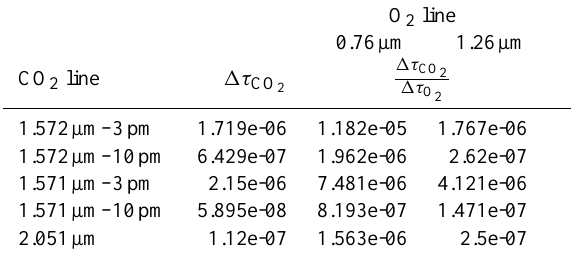
Table 1. Temperature- and humidity-induced weighting function (cid:49)τ CO2 relative uncertainty for (cid:49)τ CO (first column) and . The val- (cid:49)τ O2 2 ues for σ (cid:49)ξ (h) were computed using Eqs. (A7–A9) and the pro- ((cid:49)τ CO ) , while files in Figs. 4 and 5. The value for (cid:49)τ CO is σ 2 (cid:49)ξ 2 2 (cid:16) (cid:49)τ (cid:17) (cid:49)τ CO2 CO2 (cid:49)τ 2 for the relative uncertainty value is σ 2 . (cid:49)ξ (cid:49)τ O2 (cid:49)τ O2 O 2 All computations assume constant profiles of 400ppm of CO 2 and 21% of O 2 . Note the larger magnitude of the 0.76µm uncertainties, which arises from the larger covariances depicted in Fig. 5. Also note that only in the case of the 1.572µm–10pm CO 2 instrument paired with the 1.26µm O 2 instrument is the ratio less sensitive to the environmental errors than the (cid:49)τ CO measurement alone. 2